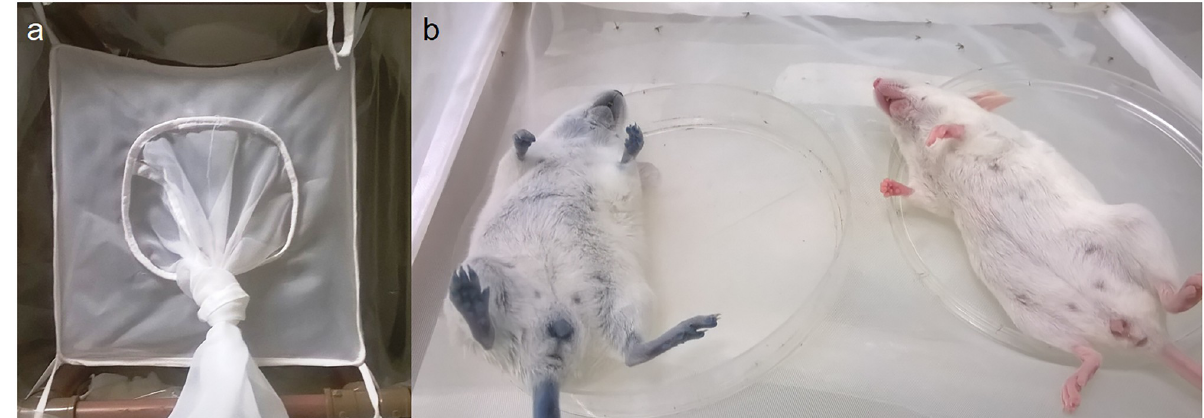
Fig 1. Bioassay in a Barraud cage to investigate the attractiveness of infected and uninfected mice to Ny . neivai . (a) Barraud cage; (b) mice in Petri dishes inside the cage—injected or not with Evans Blue dye.